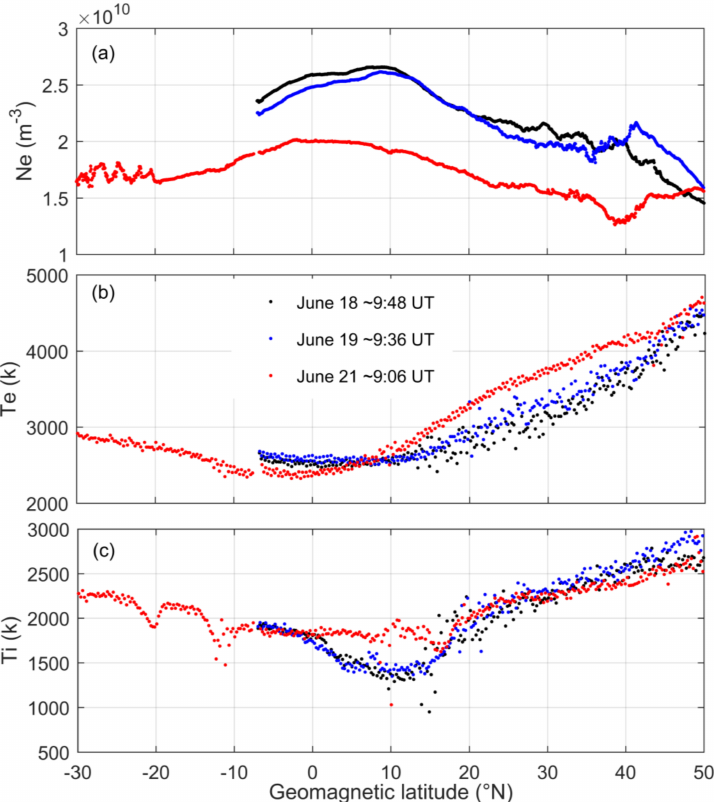
Figure 5. DMSP F17-observed ( a ) electron density ( N e ), ( b ) electron temperature ( T e ) and ( c ) ion